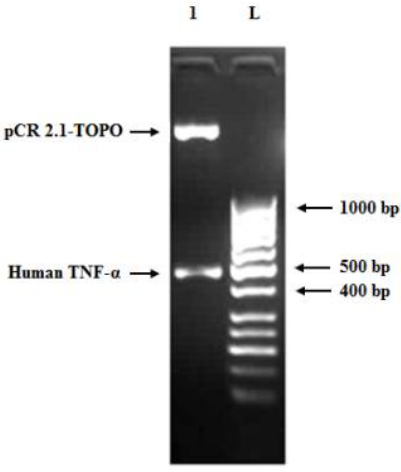
Figure 5. Agarose gel (1.2%) of restriction digestion of a positive clone carrying pCR 2.1-TOPO-human TNF-α recombinant plasmid using EcoR I enzyme at 37 °C for 1 h. Lane L: 50 bp DNA ladder and lane 1: pCR 2.1-TOPO vector fragment (3.881 bp) and human TNF-α insert band (505 bp, comprising full-length gene size of 474 bp, restriction enzymes sites of 12 bp and 19 bp from the vector cloning site).